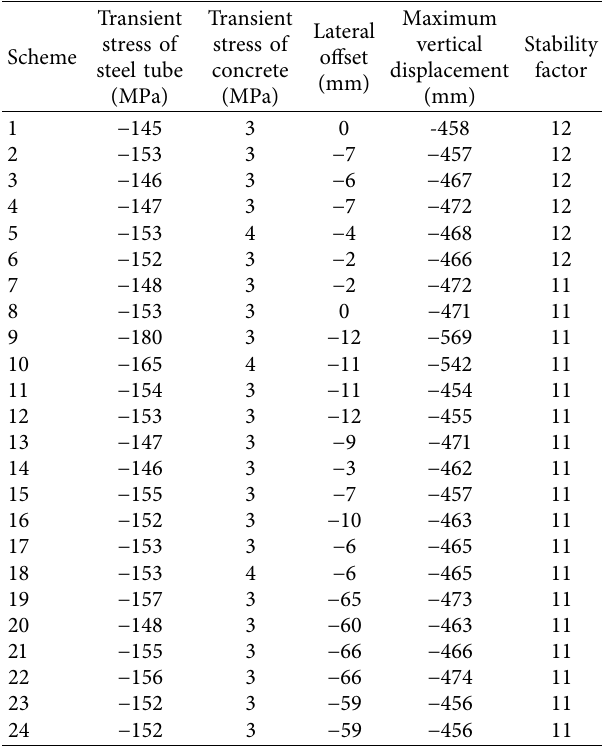
Table 2: Initial quantization value